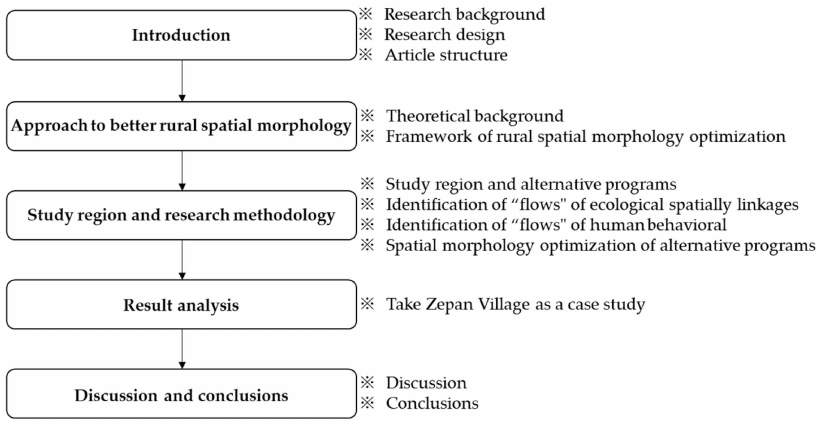
Figure 1. Flowchart of the research